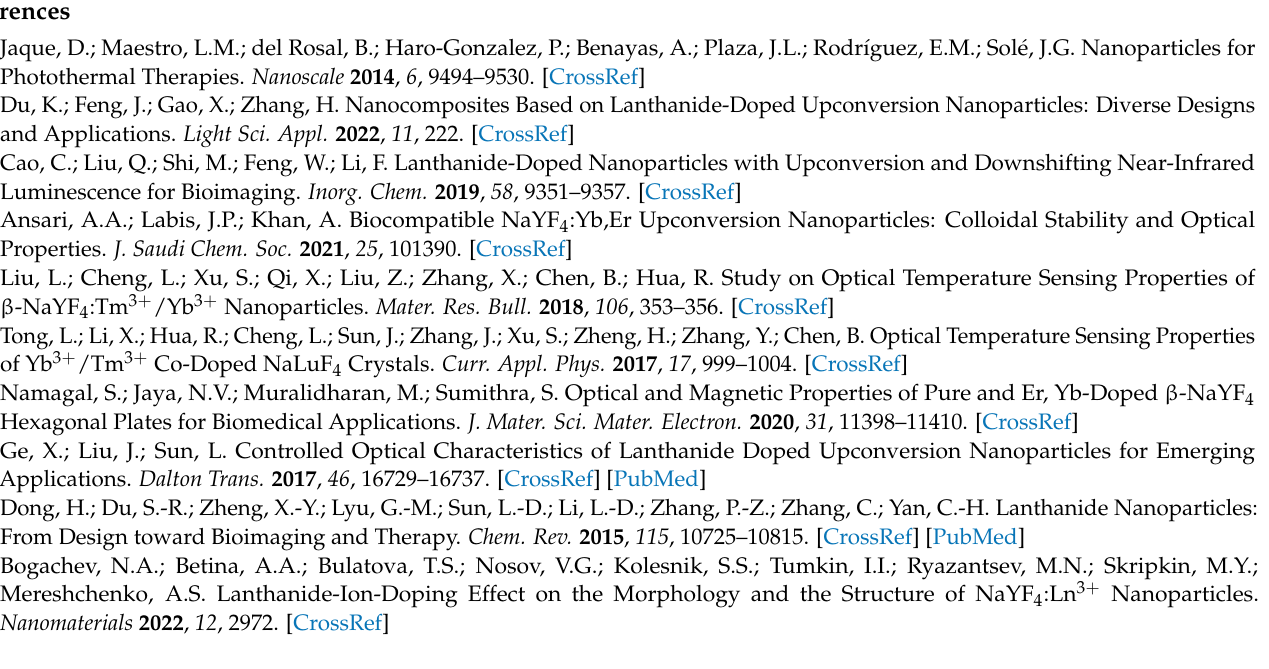
powders; Table S8: Pre-exponential constants, fitting lifetimes and average luminescence lifetimes of NaY (0.98 − x) Sm 0.02 La x F 4